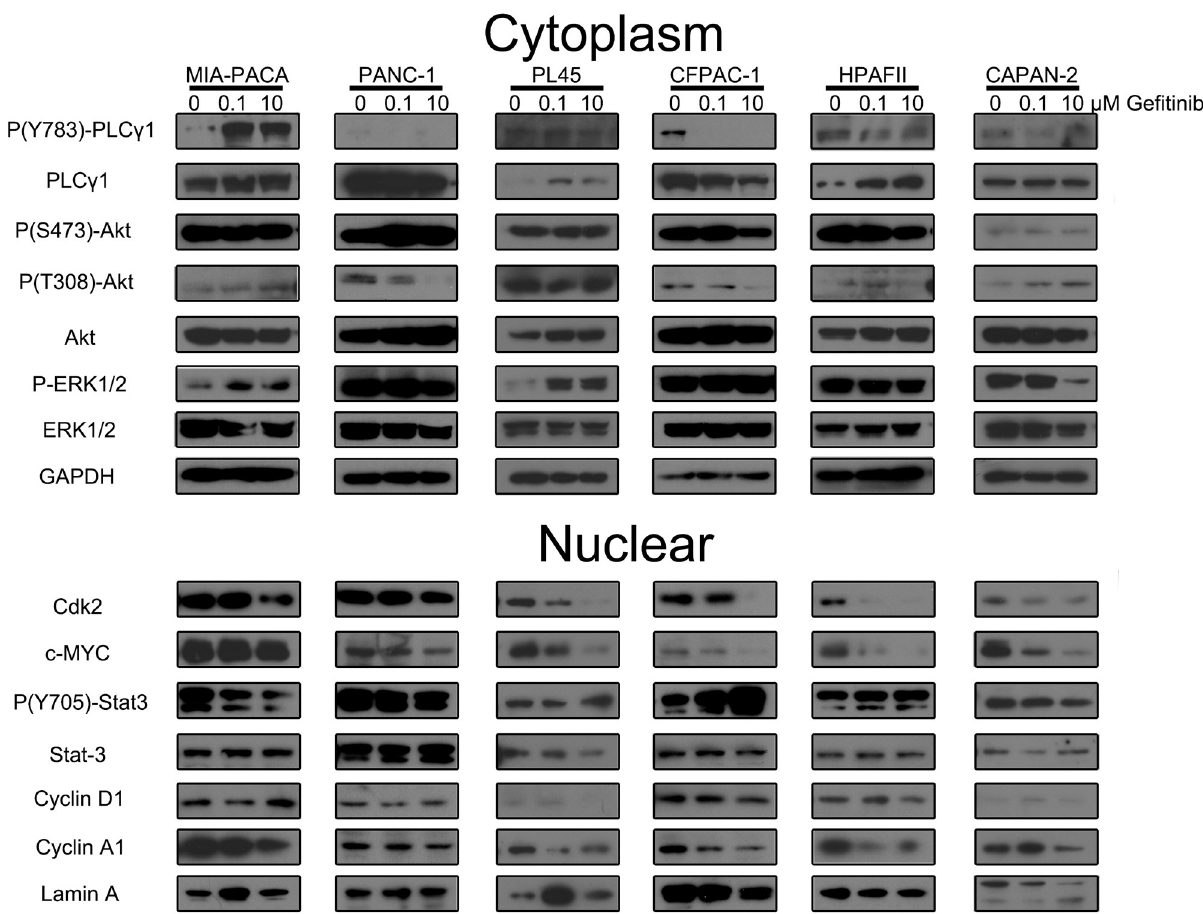
Fig 3. Effects of gefitinib on EGFR downstream signaling pathways. PDAC cell lines were treated with 100 nM gefitinib, 10 μ M gefitinib or vehicle control for 24 hours, cells were lysed and fractionated to cytoplasmic and nuclear fractions. Western blots were used to detect total or phosphorylated protein changes in the EGFR downstream signaling pathways in the identified cellular compartments. GAPDH was used as the cytoplasmic protein internal control and Lamin A was used as the nuclear protein internal control.